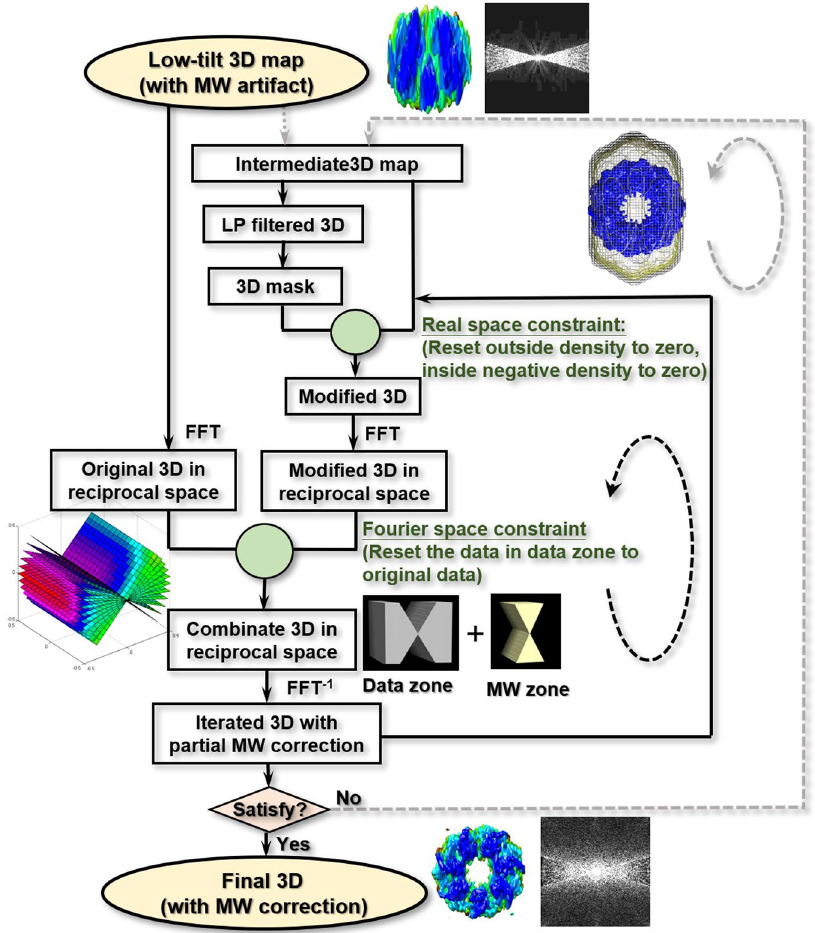
Figure 2. Flowchart of the missing-wedge correction algorithm. The iterative procedure includes the following steps: (i) use a reconstructed 3D density map to generate a mask after low-pass filtering; (ii) apply the mask to the 3D map to remove all densities outside the mask; (iii) reset the negative densities inside the mask to zero (remove imaginary parts if any exist); (iv) Fourier transform the masked/modified 3D map; (v) replace the data within the data zone with the original data (the tile series or initial data); (vi) inverse Fourier transform to the real space to obtain the first corrected 3D map; (vii) repeat the above steps from (ii) to (vi) for 1,000 iteration cycles (referred to as round 1 or Rd_1) to achieve a convergent 3D map. If the result is unsatisfactory, additional rounds are required, in which a new mask is generated from the output map of the last